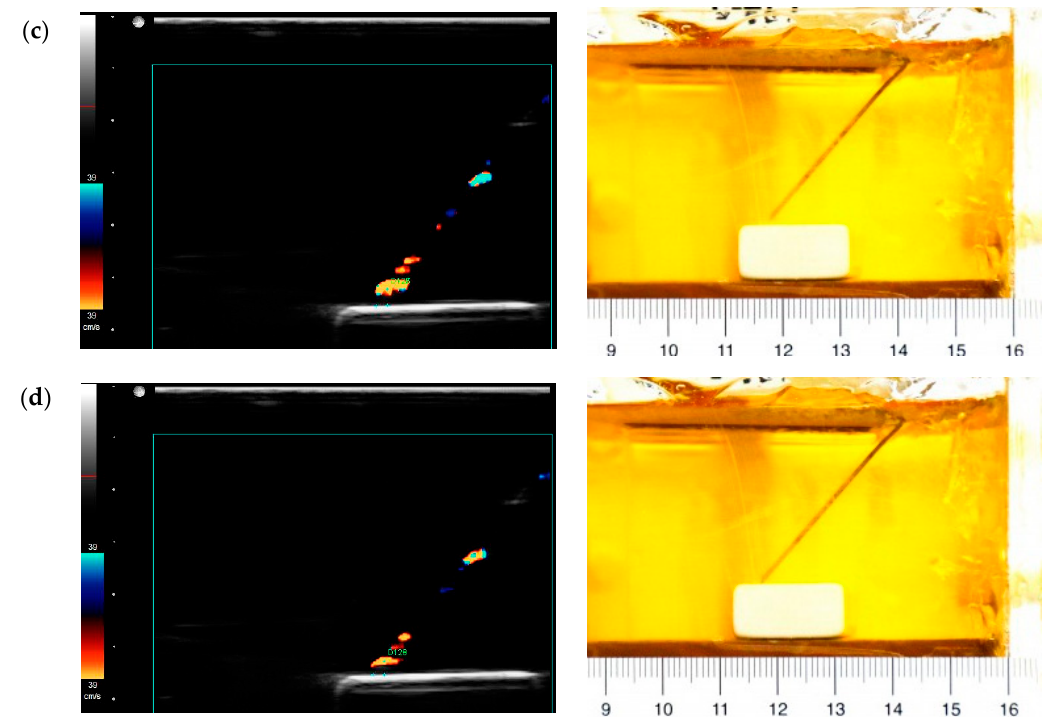
Figure 8. Paired images obtained from the Doppler ultrasound ( left ) and photographs ( right ) when the distance is about ( a ) 1.5, ( b ) 1, ( c ) 0.5, ( d ) 0 mm.